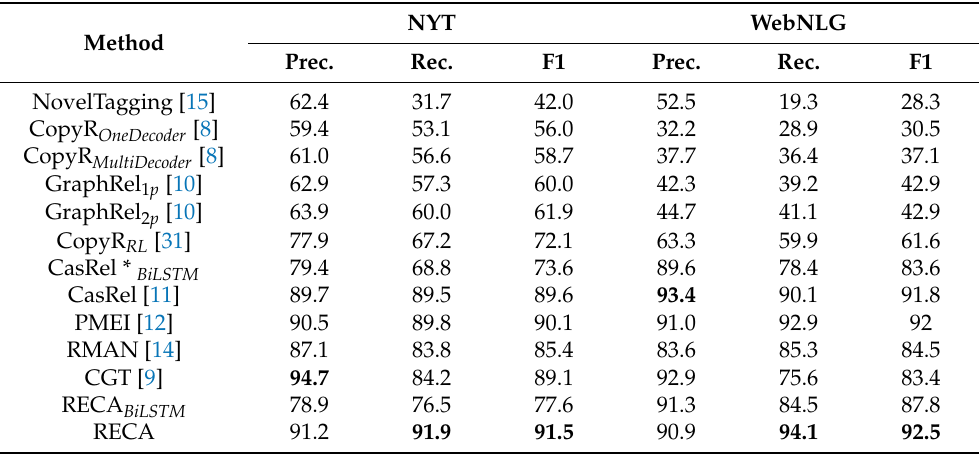
Table 2. Experimental results for different models and the NYT and WebNLG datasets. Our re- implementation is marked by *. The best scores are in bold font.